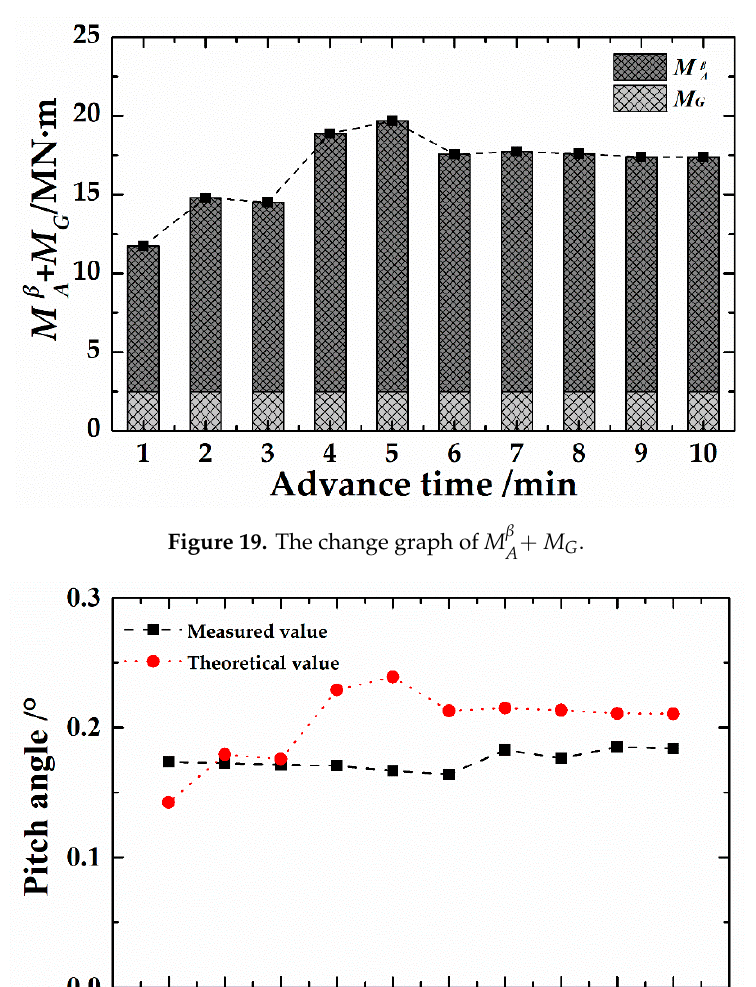
Figure 20. Contrast between the measured and the theoretical value of the shield pitch angle